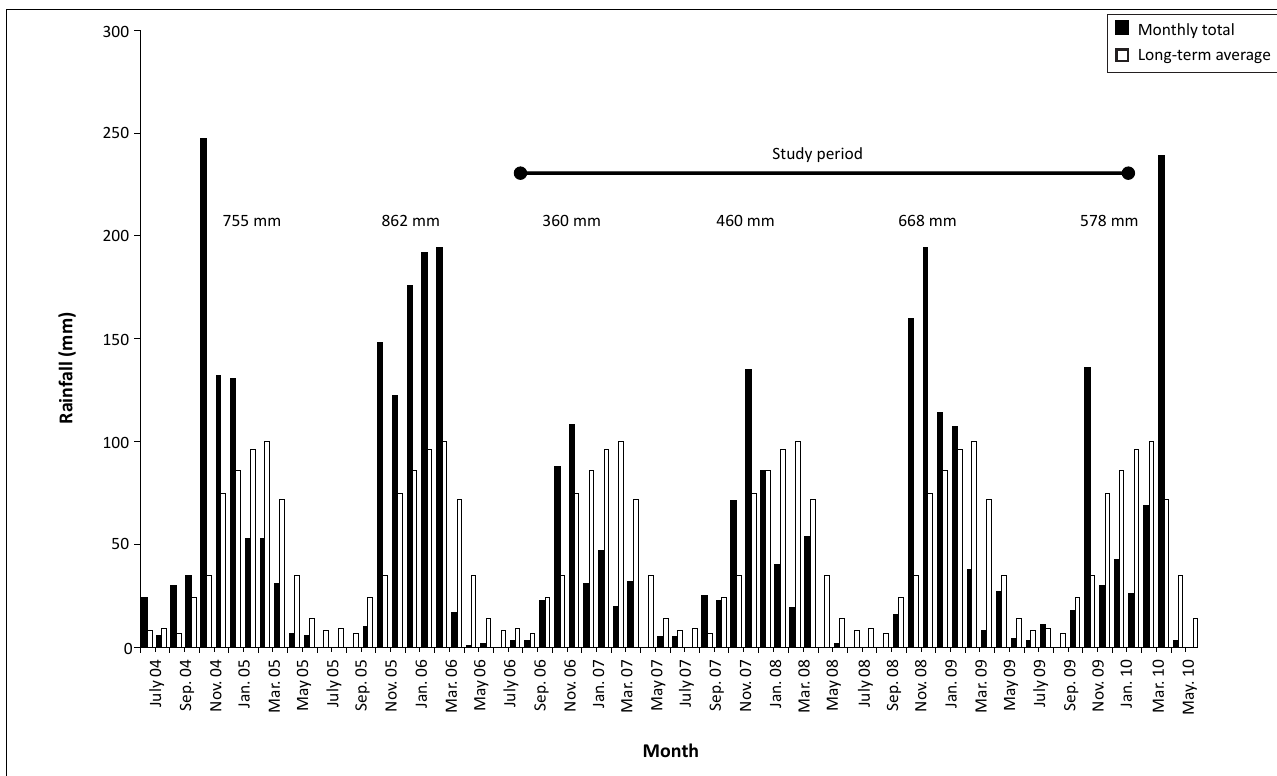
FIGURE 1: Monthly rainfall at Skukuza for the duration of the study and two years prior to the study. For comparison, long-term average monthly rainfall is also shown. Total annual rainfall for each year (July to June) is indicated above the